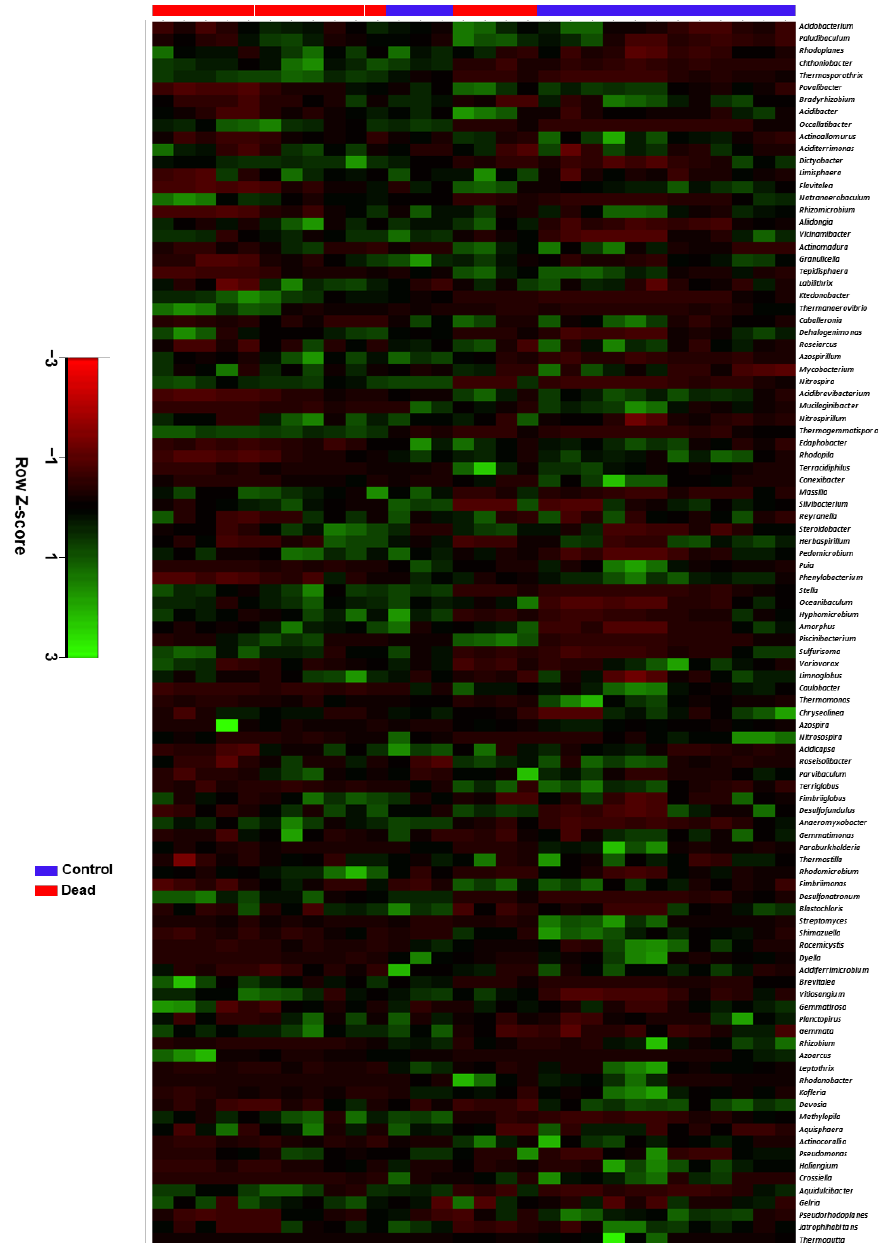
Figure 5. Heatmap based on the Euclidean distance measurement and the average linkage hierarchical clustering of the top 100 most abundant bacterial genera in the rhizosphere of Korean fir trees. A distinction was noticed between the control and the standing dead trees based on the differences in the abundance of the predominant bacterial genera. The Z-Score represents the relative abundance of the bacterial genera in each row after heatmap standardization.